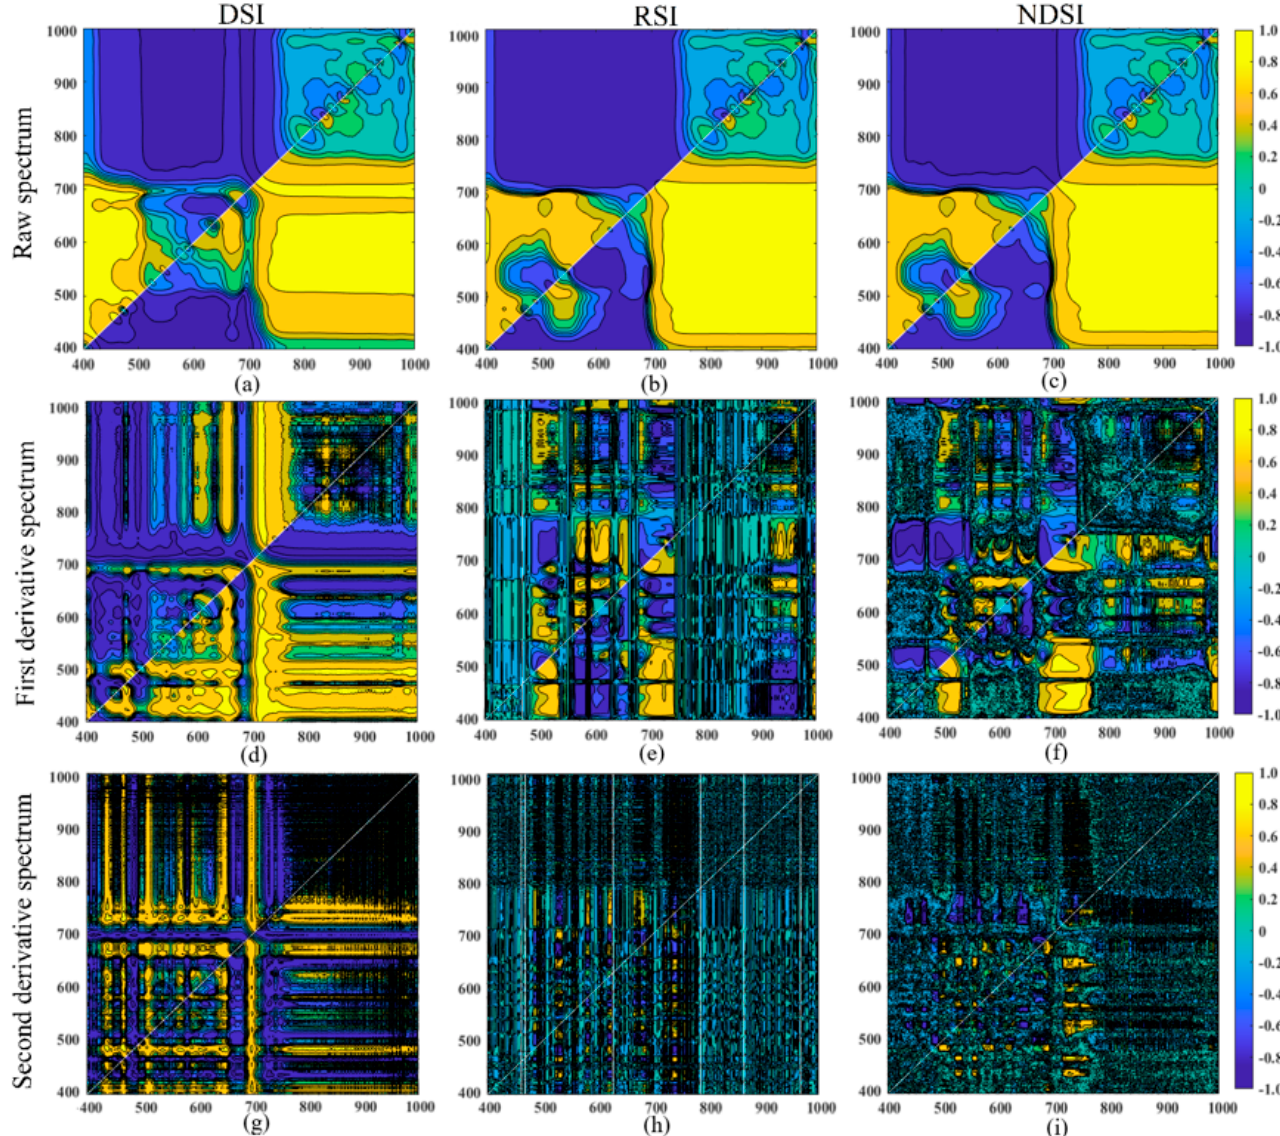
Figure 5. Matrix plots of the correlation between anthocyanins and DSI, RSI, NDSI: ( a – c ) constructed by raw spectrum; ( d – f ) constructed by first derivative spectrum; ( g – i ) constructed by second derivative spectrum. Table 2. Selected wavelengths, formulas, and the correlation coe ffi cient between anthocyanins and the spectral index.